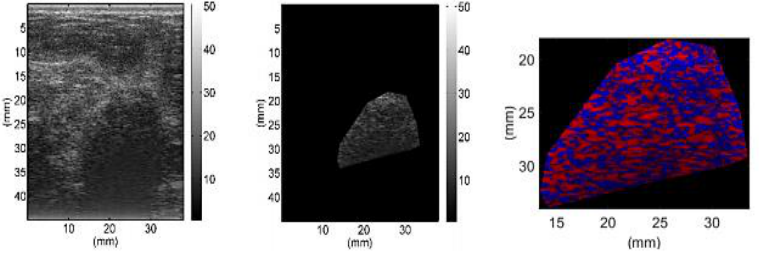
Figure 15. Ultrasound images of benign breast tumors and H-scan images [105].